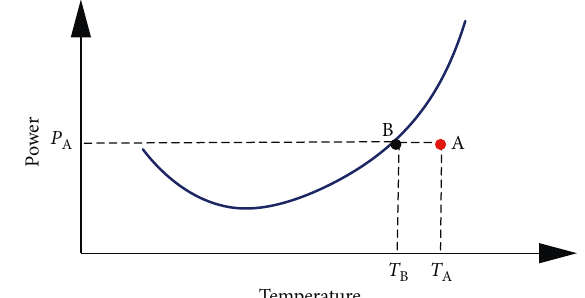
Figure 9: Effective temperature transition schematic